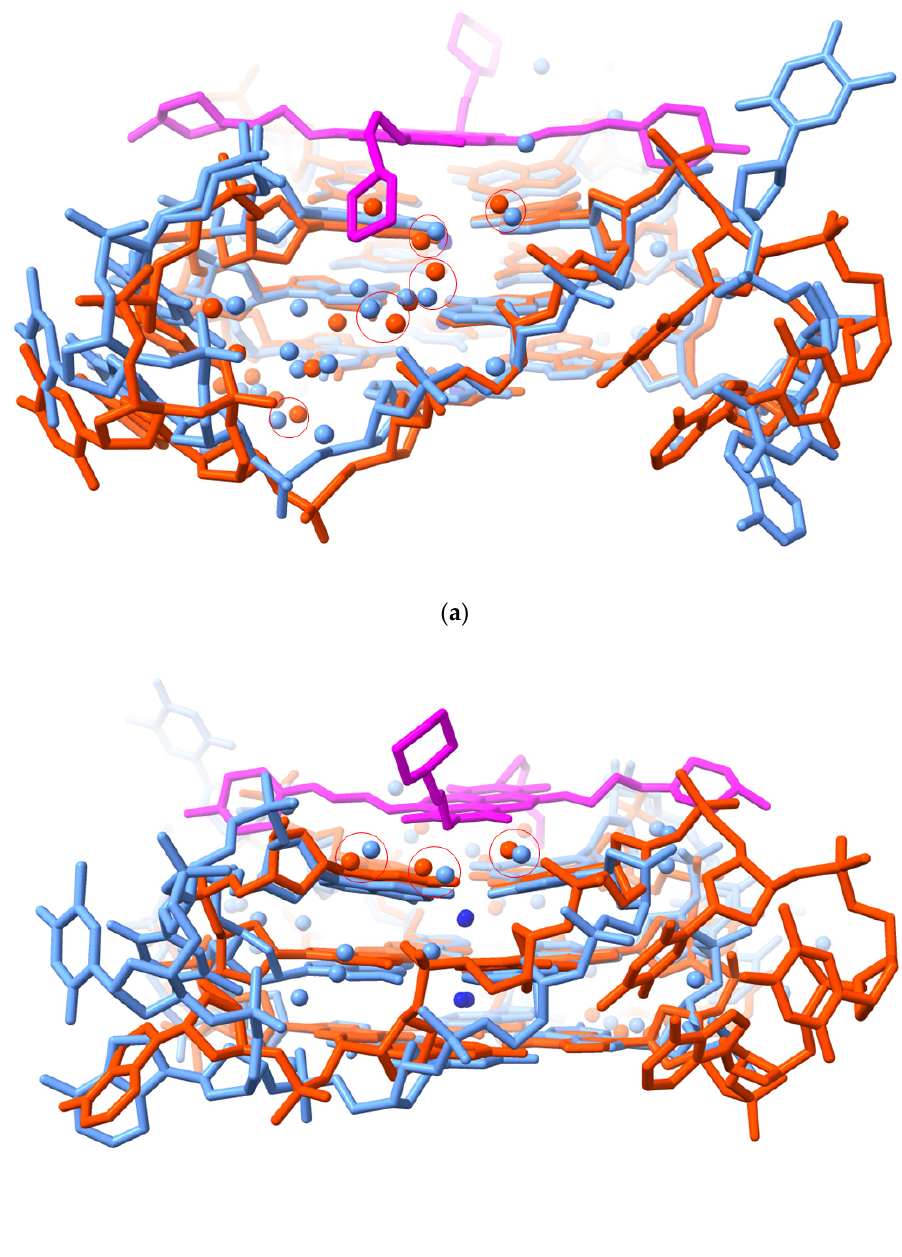
Figure 4. Superposition of the G-quartets of native and MM41-complexed G-quadruplex crystal structures, 1KF1 and 3UYH, respectively, viewed into groove 1. The native structure is colored light red, the ligand-bound is cyan, and the MM41 molecule is shown magenta. Only the water molecules in the groove are shown, colored as in their G-quadruplex structures. Those water molecules in the two structures that are < 1.0 Å to each other are enclosed in red circles. ( a ) Viewed into groove 1. ( b ) Viewed into groove 3.